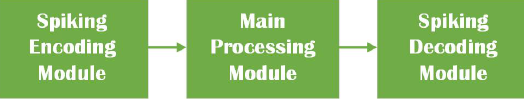
Figure 1. The overall structure of our SNN.